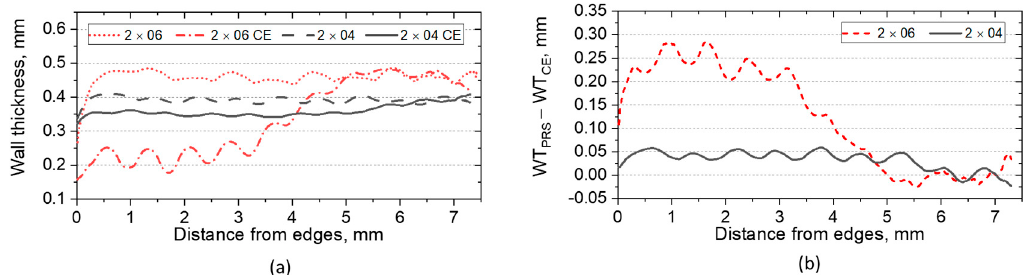
Figure 9. ( a ) WT as a function of distance to the edges; ( b ) the difference between as-build (PRS) and CE WT as a function of distance to the edges.